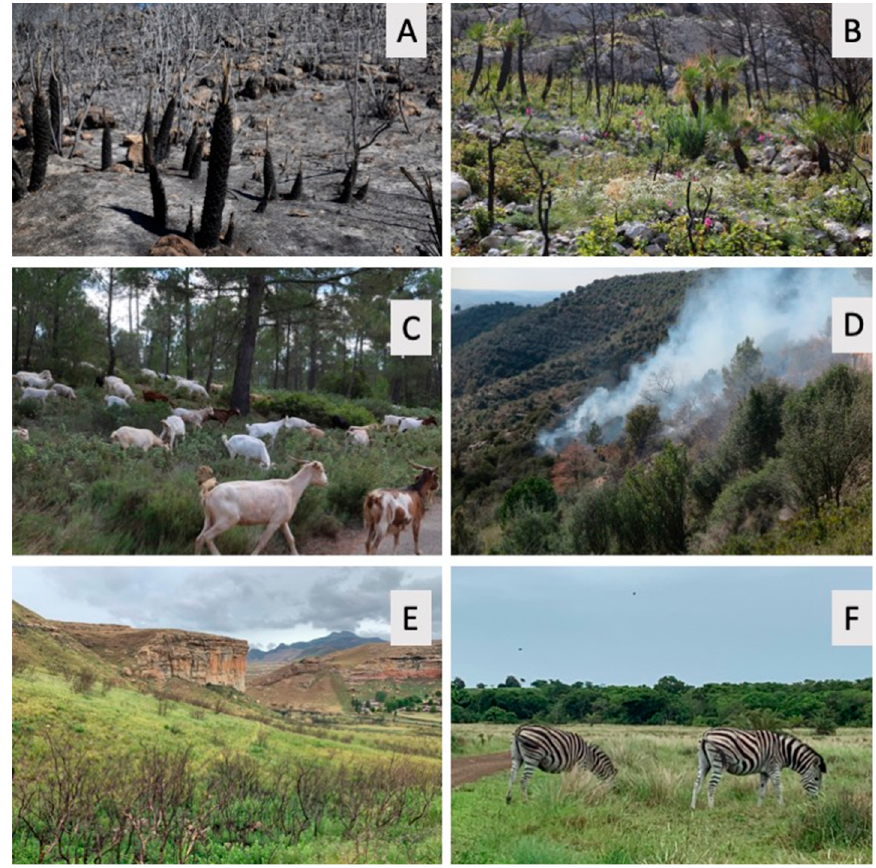
Figure 1. Fire and grazing shapes the landscape of the world. ( A ), Recently burnt (2 days) Mediterranean macchia in Carcaixent (València province, Eastern Iberian Peninsula) June 2016. ( B ), Vegetation recovery after the fire of Cala de la Granadella (Alacant province, Eastern Iberian Peninsula) April 2017 (wildfire August 2016). ( C ), The use of goats to reduce fuel at the Bicorp (Massís del Caroig, inland Valencia Province, Eastern Iberian Peninsula). ( D ), Prescribed fire in Olesa de Montserrat, Catalonia, Janauary 2017. ( E ), View of the recently burnt area by shepherds at the Golden Gate Highlands National Park, Free State, South Africa (December 2019). ( F ), Natural grazing act as a vegetation biomass control. Zebras grazing in Hluhluwe Infolosi Park, KwaZulu Natal South Africa (December 2019). Photographs by Artemi Cerdà.